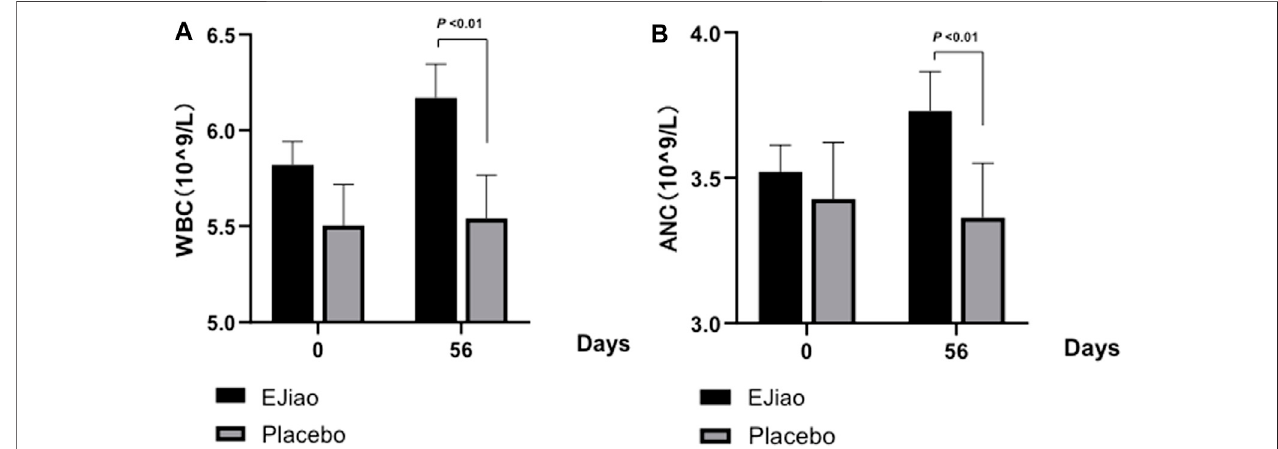
FIGURE 3 | Changes in WBCs and ANC between the Ejiao and placebo groups in 56 days. After 56 days of administration of Ejiao (3 g, BID), the WBCs (A) and ANC (B) were signi fi cantly increased in the Ejiao group compared to the pretreatment stage and placebo group, while there were no signi fi cant changes in the placebo group after the treatment of Ejiao. The data are expressed as mean ± standard deviation. p -value is analyzed by independent samples t-test.